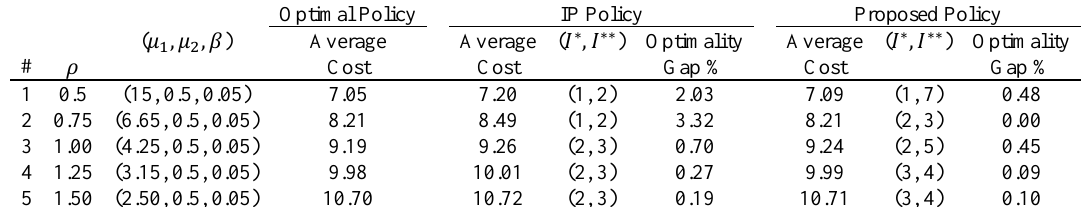
Table 6. Performances of the alternative policies: DFR cases with s=2 and K=0